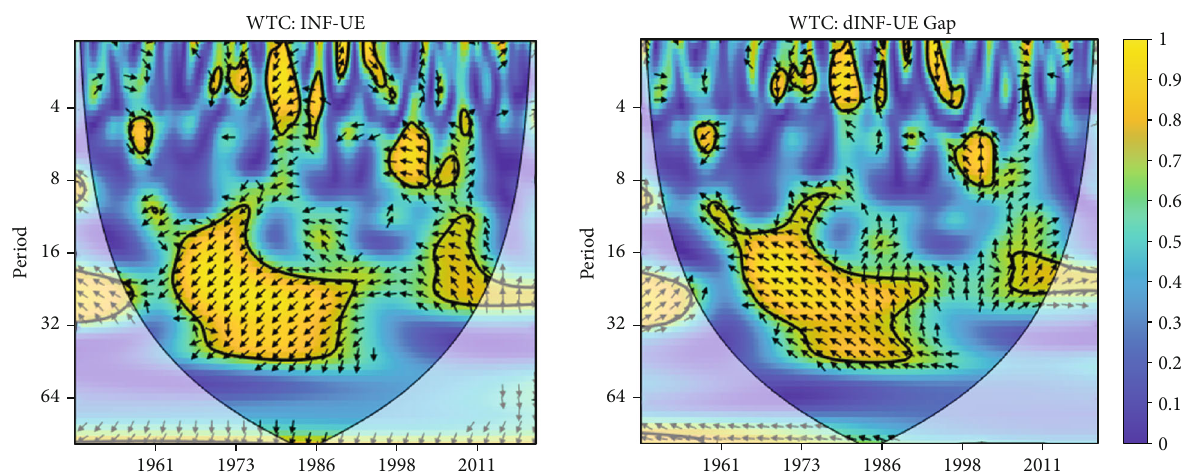
Figure 5: Wavelet coherence. The x -axis represents time space while the y -axis represents frequency space (de fi ned by quarters). The color coding indicates coherence, with blue and yellow representing low and high coherence, respectively. The regions enclosed by a black line denote statistical signi fi cance at the 5% signi fi cance level relative to a null hypothesis of a nearly process-independent background power spectrum. The arrows describe phase di ff erence, with arrows pointing leftward signifying antiphase and rightward signifying in-phase. The arrows ’ tilt up or down re fl ects the lead-lag relationship. The cone of in fl uence, represented by the lightly shaded region from the cone outline to the axes, shows areas that may be impacted by edge e ff ects (i.e., e ff ects arising from wavelets stretched beyond the edges of the observation interval); the observed representation of the data in this shaded region should be interpreted with